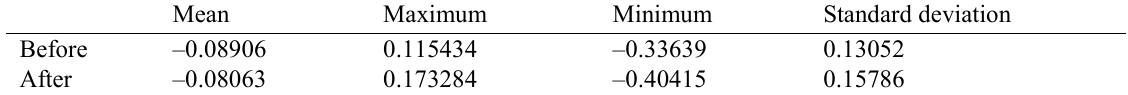
Fig. 3 NDVI Comparison between before and after FLAASH atmospheric correction Table 3 Data of NDVI comparison between before and after atmospheric